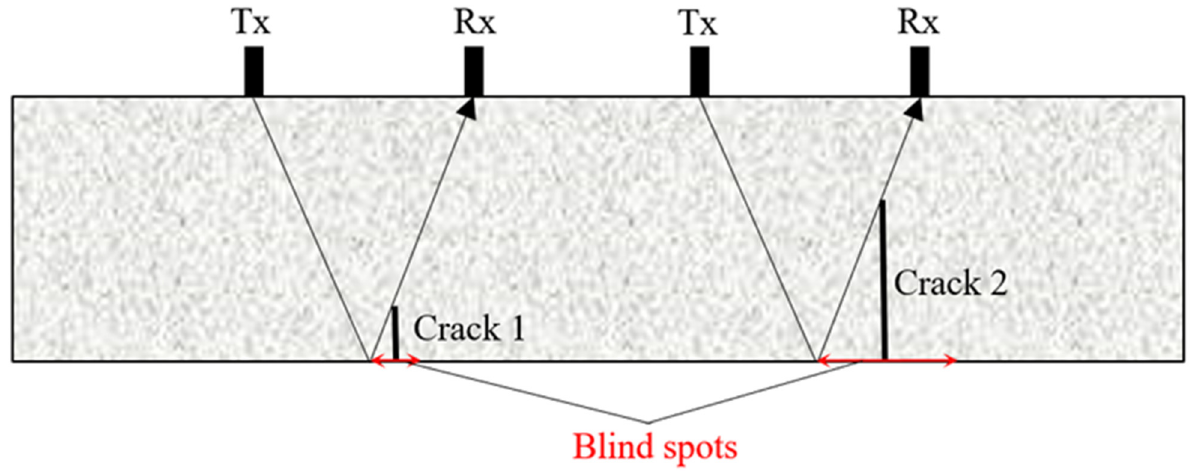
Figure 13. E ff ect of crack depth on backwall visualization. Figure 13. Effect of crack depth on backwall